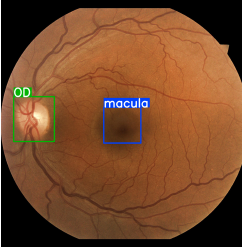
Figure 7. Anatomic interest areas for object detection macula and optic disc